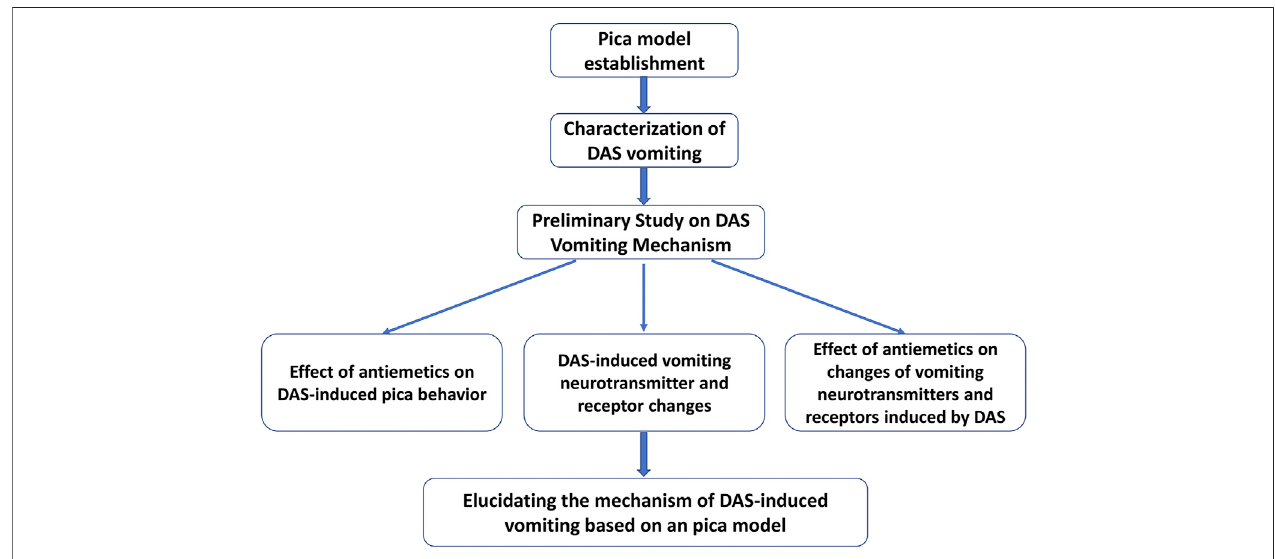
FIGURE 1 | The fl owchart of this